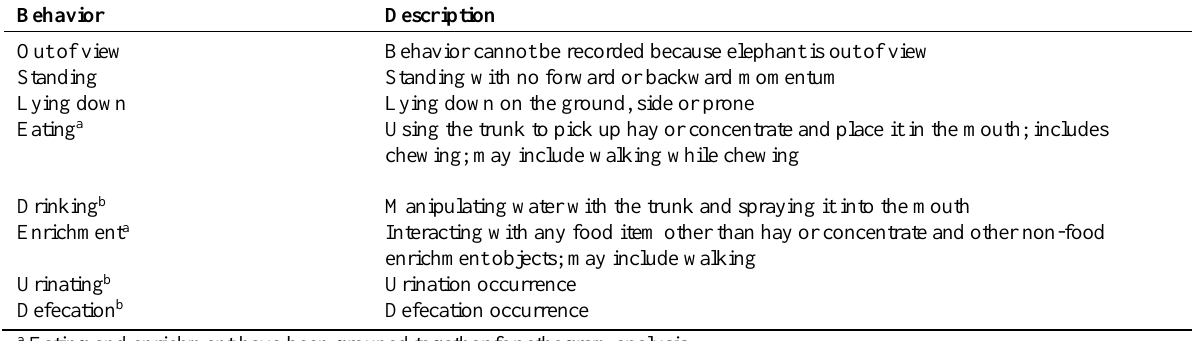
Ethogram Key of Mutually Exclusive Behaviors Recorded During Nocturnal Observation Periods Behavior Description